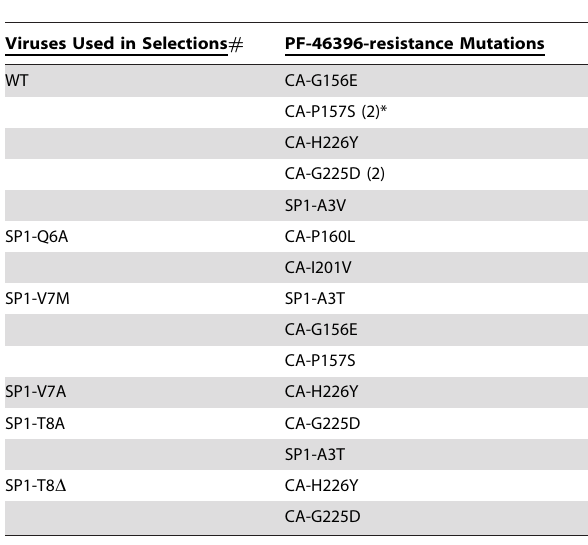
Table 1. Summary of PF-46396-resistance mutations